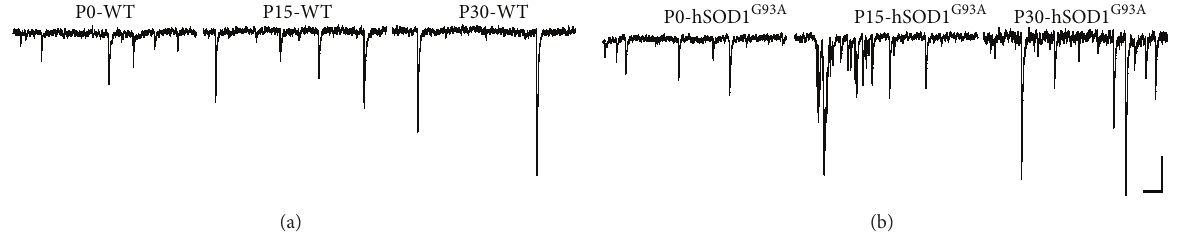
Figure 7: Developmental changes in the amplitude and frequency of spontaneous excitatory postsynaptic currents (EPSCs; downward deflections) in hypoglossal motoneurons recorded from the C57/Bl6 WT mice (a), compared to the mice overexpressing the mutated human SOD 1 G 93 A gene (b) at P0, P15, and P30. The amplitude of EPSCs increased by ∼ 3-fold, while the frequency of EPSCs reduced by ∼ 50% with postnatal maturation (from P0 to P30) in WT mice. In the mutated hSOD 1 G 93 A mice the frequency of EPSCs was increased, without a clear change in EPSC amplitude, compared to age-matched WT littermates. Scale bars = 100 pA, 0.1